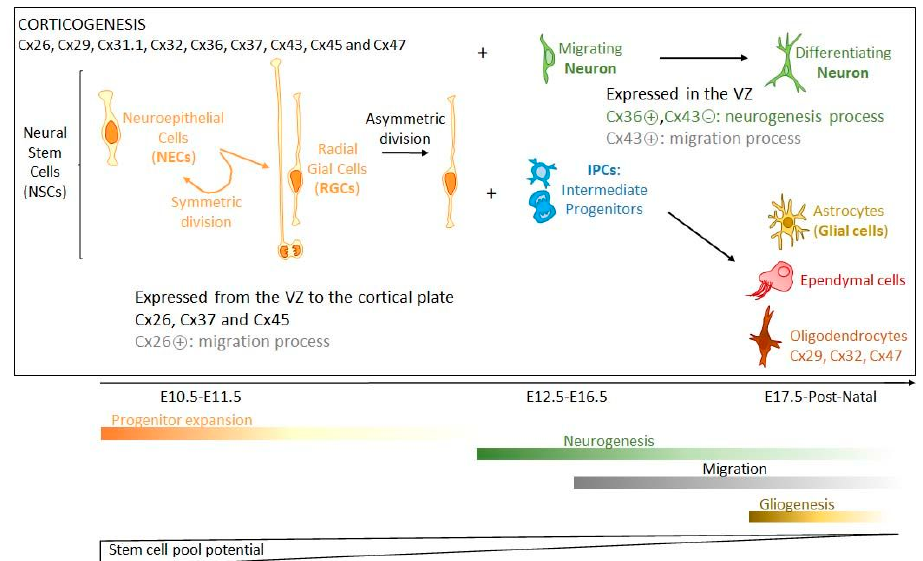
Figure 1. Corticogenesis. During early cortical development, neural stem cells (NSCs) predominantly undergo symmetric divisions to expand the NSC pool (Progenitor expansion phase). This pool includes neuroepithelial, radial glial and intermediate progenitor cells. Neuroepithelial cells (NECs) become radial glial cells (RGCs), which by asymmetric divisions generate RGC and intermediate progenitors (IPCs) or neurons, both migrating and differentiating (Neurogenesis phase). At later stages of development, NSCs generate the other cell types of the brain including astrocytes, oligodendrocytes, or ependymal cells (Gliogenesis phase). During cortical development, Cx37 and Cx45 are largely distributed from the VZ to the cortical plate, whereas Cx36 and Cx43 are highly expressed in the VZ and less in the cortical plate. While Cx43 is a negative modulator of neuronal differentiation, Cx36 activates this process (in green). Cx26 and Cx43 are involved in neocortical neuronal migration (in grey). The differentiation of oligodendrocytes is accompanied by the expression of specific Cxs (Cx29, Cx32, Cx47) that are involved in the postnatal myelination process. The time scale of these phases of corticogenesis (E: Embryogenesis days) is from mouse [136].